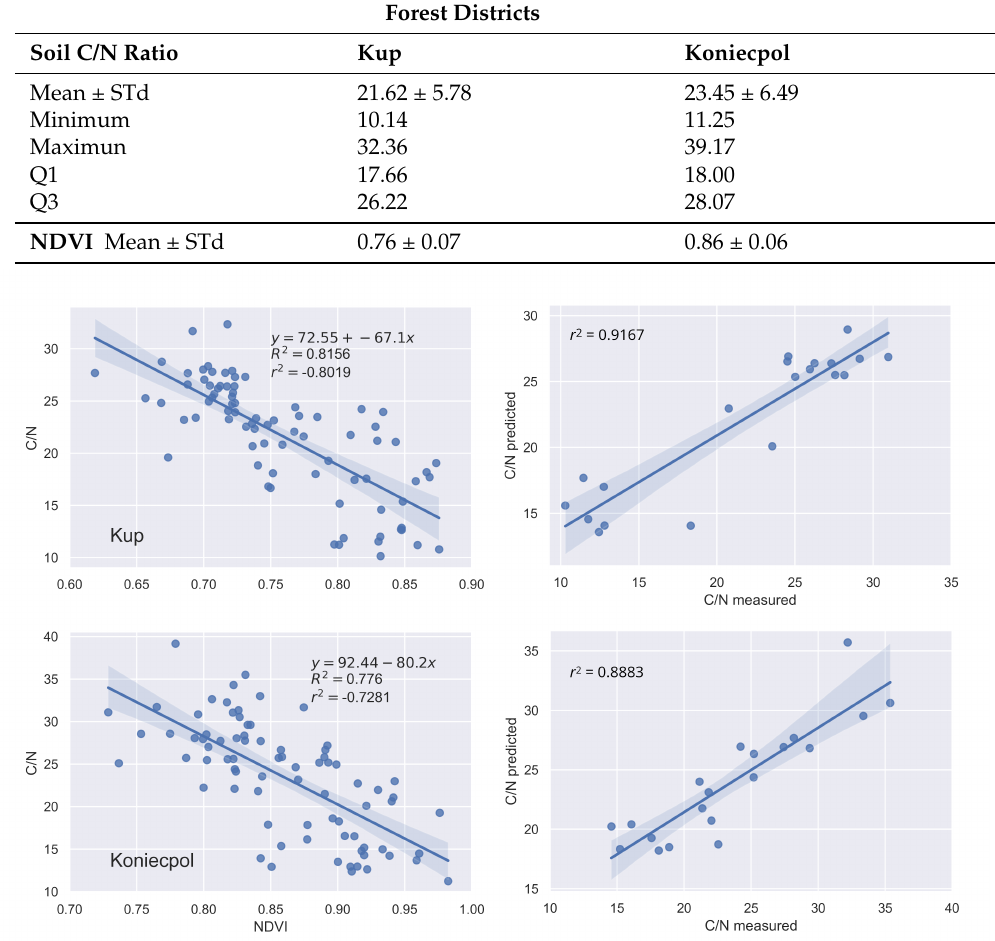
Figure 4. Regression analysis for the Kup ( top ) and Koniecpol ( bottom ) forest districts. The plots on the left show the measured C/N ratio, while the plots on the right show the predicted